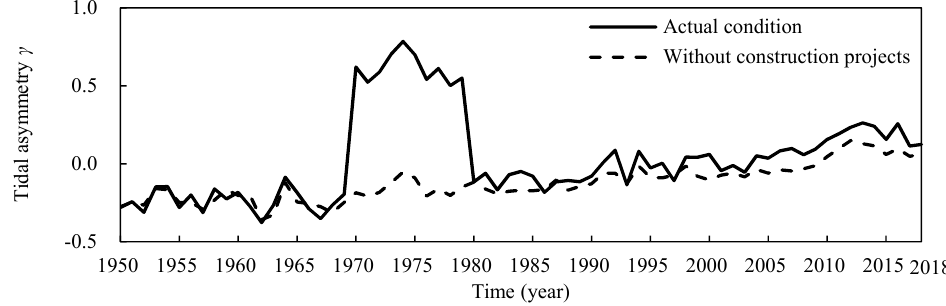
Figure 23. Variations of tidal asymmetry with time with (solid line) and without construction project of tide gate (dashed line).